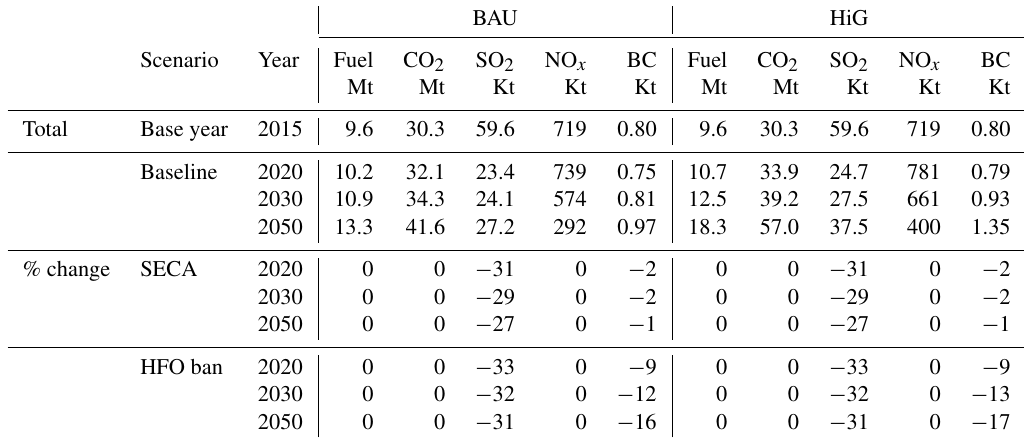
Table 1. Total shipping emissions for the Nordic (d03) domain for the base year 2015; the Baseline, SECA, and HFO ban BAU scenarios in 2020, 2030, and 2050; and percent changes between Baseline and SECA/HFO ban scenario results in 2020, 2030, and